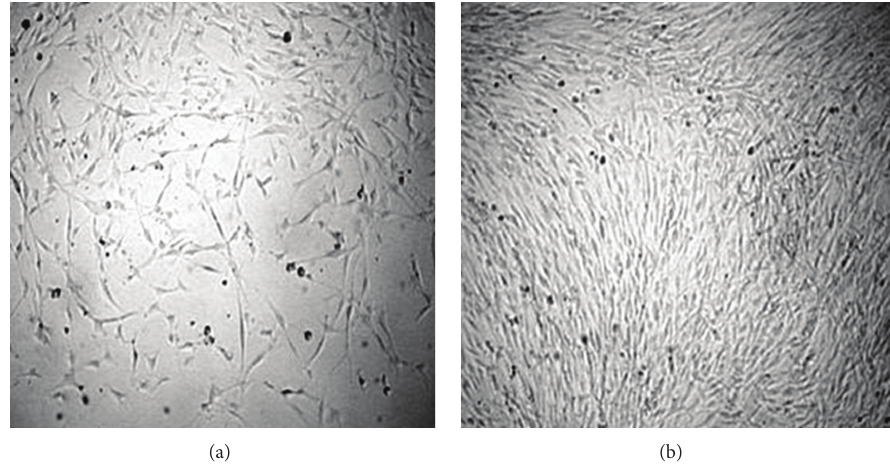
Figure 1: CD133 + /CD34 + BMMNCs in culture after 3 days (a) and 6 days